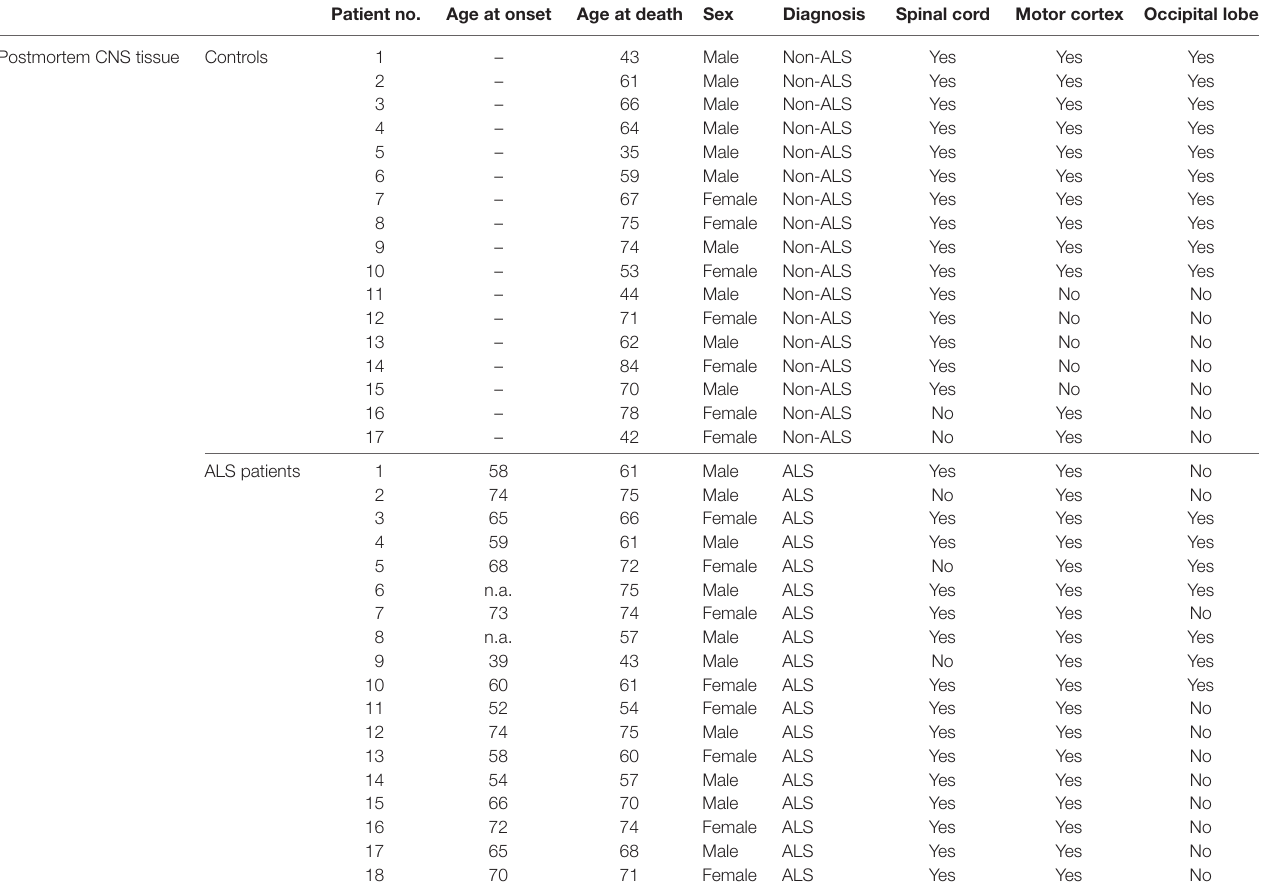
Table 2 | Characteristics of controls and ALS patients for the analysis of post mortem tissue samples with the individual ages of the controls and ALS patients at disease onset and day of death. Patient